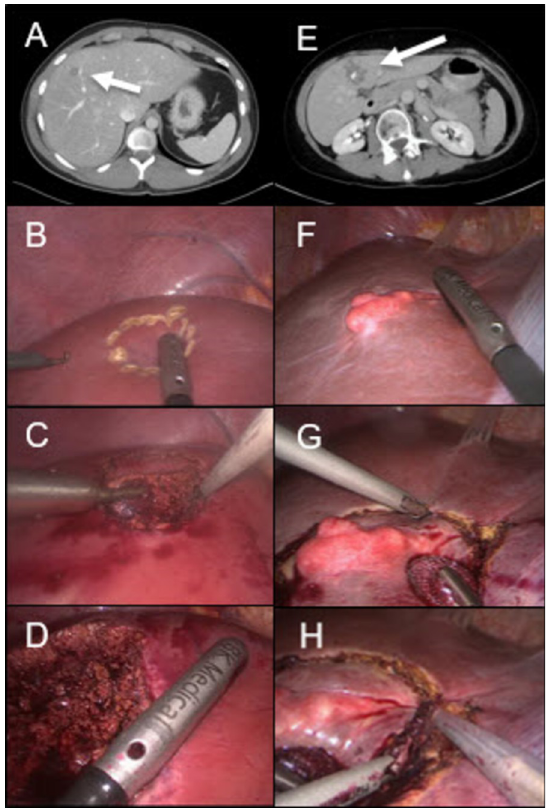
Fig 2. Laparoscopic resection of AE-lesions in two patients: In the first patient, CT-scan shows a small lesion in central liver segment 4a/b (A). Prior to resection an intraoperative sonography was made and the lesion was marked (B). The dissection of liver parenchyma was performed by an ultrasonic dissection device (C). A post-resectional sonography showed free resection margins (D). The CT-scan of a second patient shows a calcified lesion in liver segment 4b (E). This lesion could be macroscopically seen in the diagnostic laparoscopy (F). Dissection of liver parenchyma was done by an ultrasonic dissection device (G) and by ultrasonic surgical aspirator system